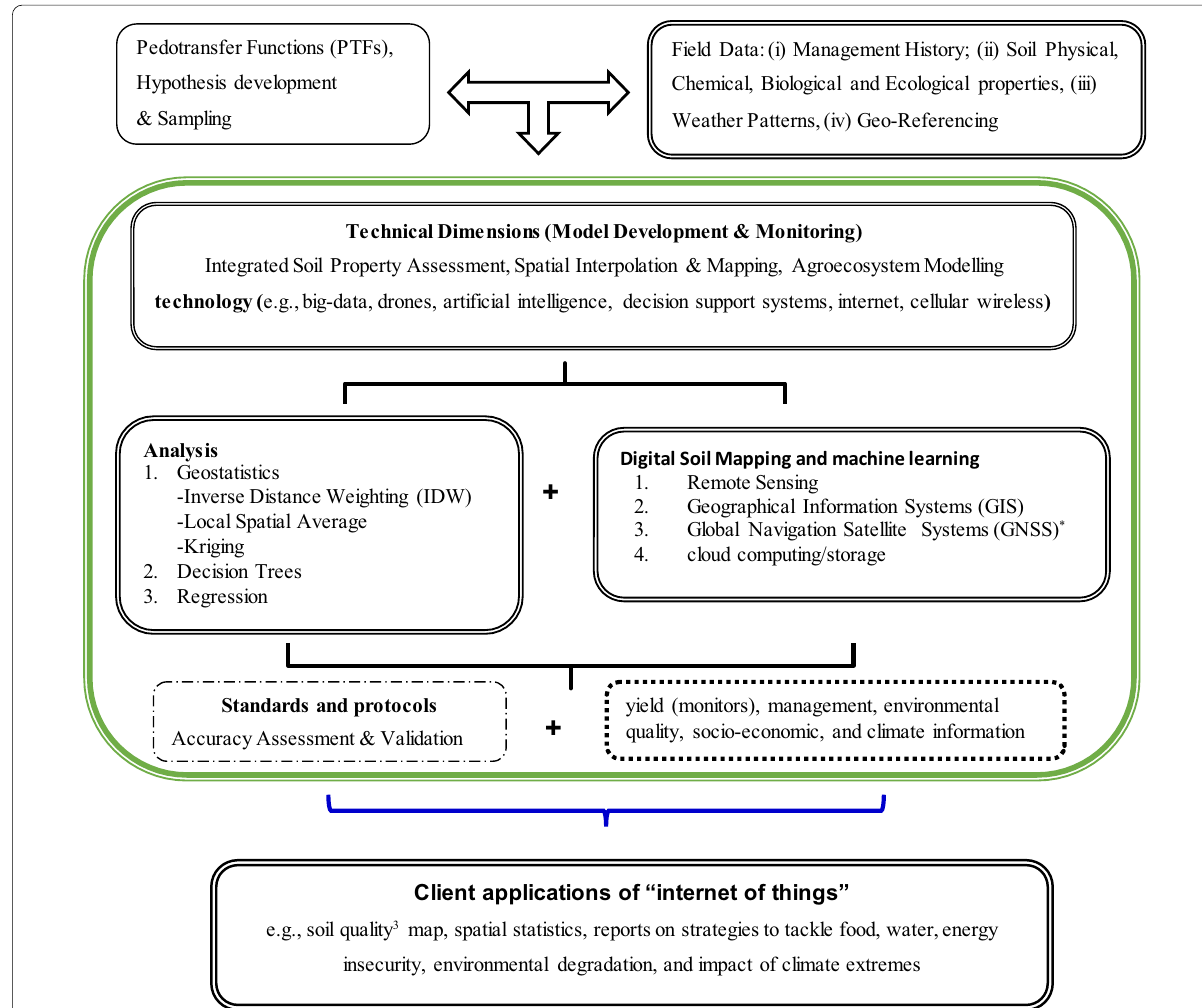
Fig. 3 Schematic of integrated digital technology system synonymous with “internet of things” for design of metric to estimate and predict soil quality to guide agroecosystem management. * Global Navigation Satellite Systems include the Global Positioning System (GPS), GLONASS, Galileo, Beidou and other systems. 3 Soil quality determined by integrating physical, chemical, biological and ecological soil